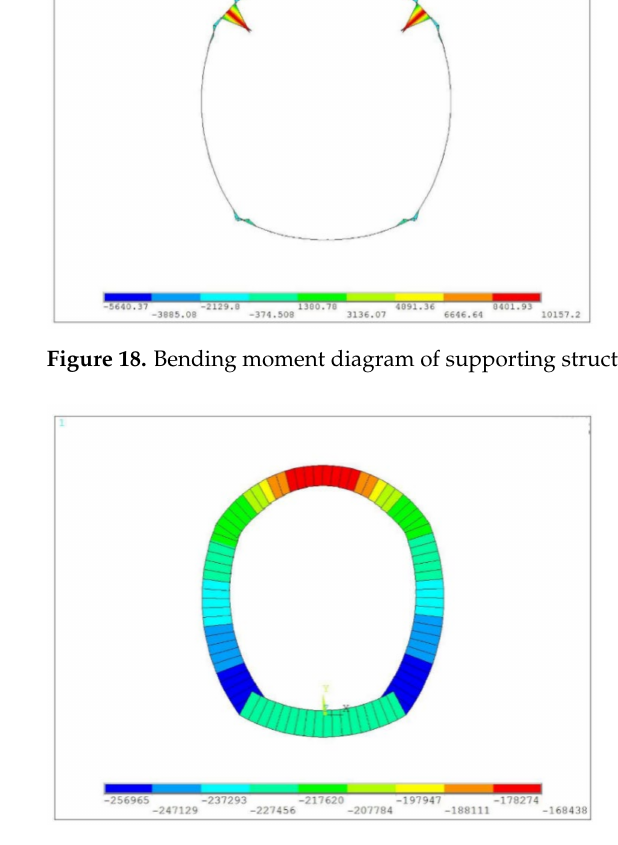
Figure 19. Axial diagram of supporting